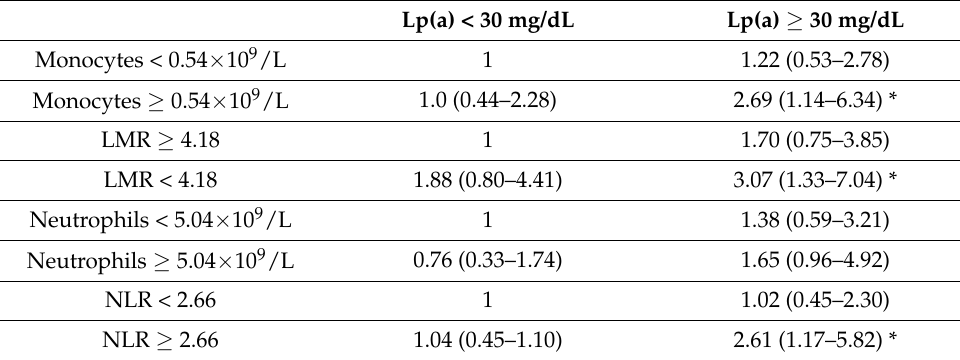
Table 3. MACE odds ratio in patients depending on Lp(a) concentration and blood immune cell distribution according to the median.